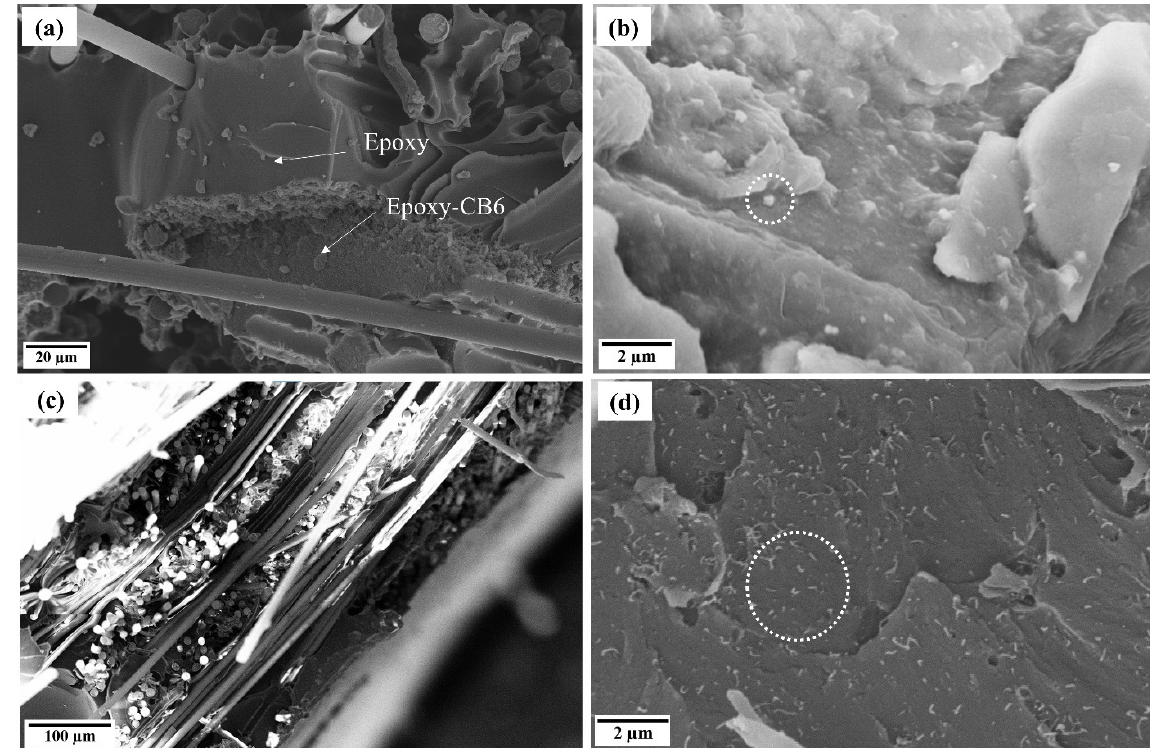
Figure 4. SEM micrographs of ( a , b ) CB6_1 and ( c , d ) CNT1_1 fractured laminate.